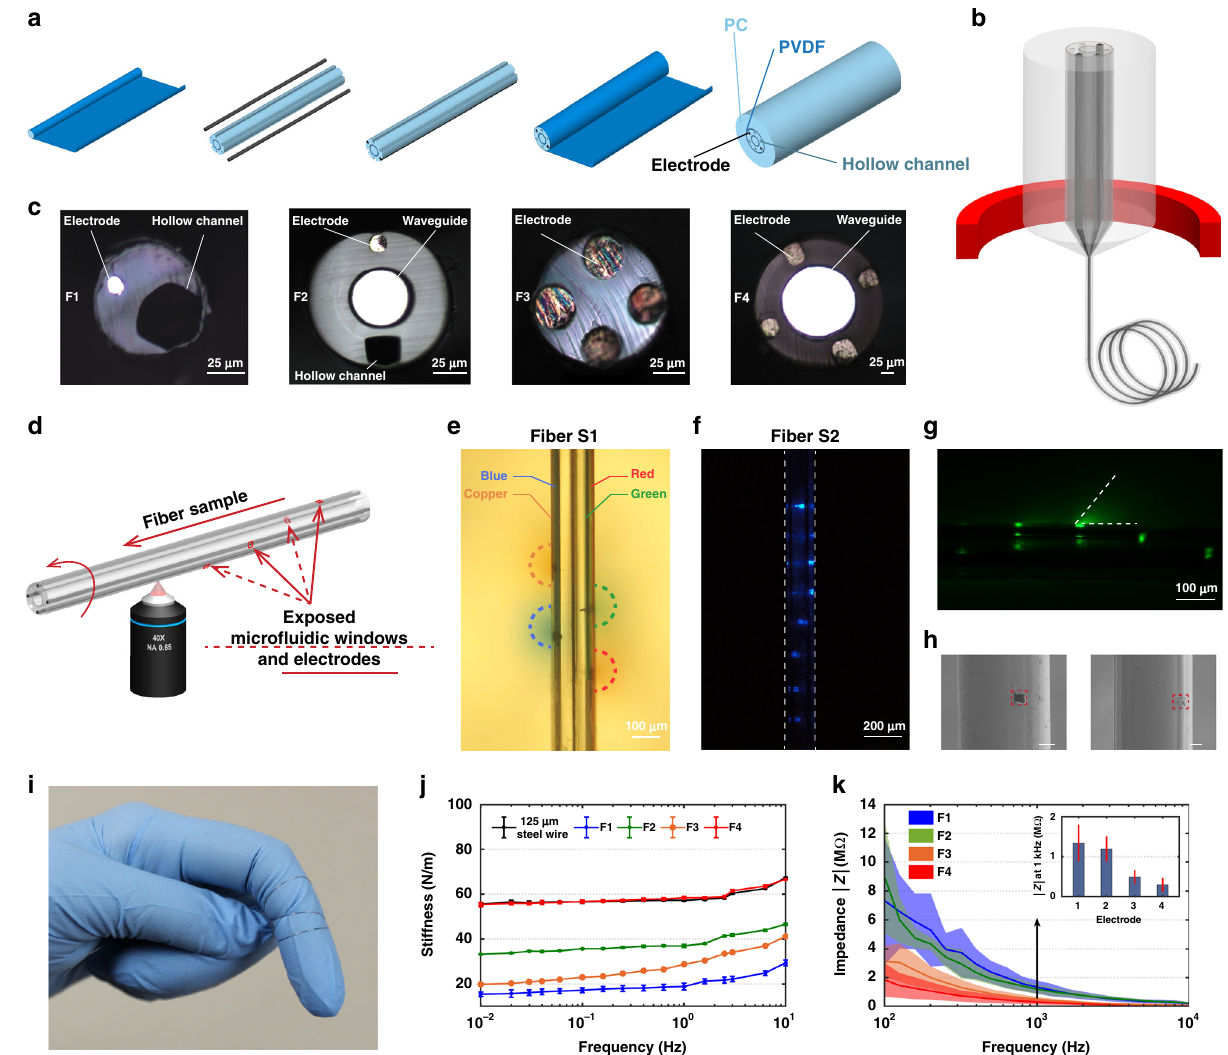
Fig. 1 Depth-dependent multifunctional fi ber probe. a A representative multifunctional fi ber preform fabrication process (Fiber S1). b A schematic of the Fiber S1 thermal drawing process. c Cross-sectional images of fi bers used in this study, electrode (BiSn). d A schematic of femtosecond laser micromachining process on Fiber S1. e – h Validation of the exposed micro fl uidic, optical excitation, and electrical windows: e four micro fl uidic windows were created on the four hollow channels of Fiber S1 and four different food colors were injected into the four channels respectively while the fi ber was embedded in brain phantom; f an optical image showing the eight optical excitation sites fabricated on the eight waveguides of Fiber S2; g optical microscope image of the exposed Fiber S2 immersed in a drop of fl uorescein excited by a 473 nm laser; h SEM images of the exposed micro fl uidic windows and electrodes (scale bar: 50 μ m). i A photograph of functional fi bers. j Bending stiffness measurements of Fiber F1 – 4. k Impedance measurements of the BiSn electrodes in Fiber F1 – 4. All error bars and shaded areas in the fi gure represent the standard